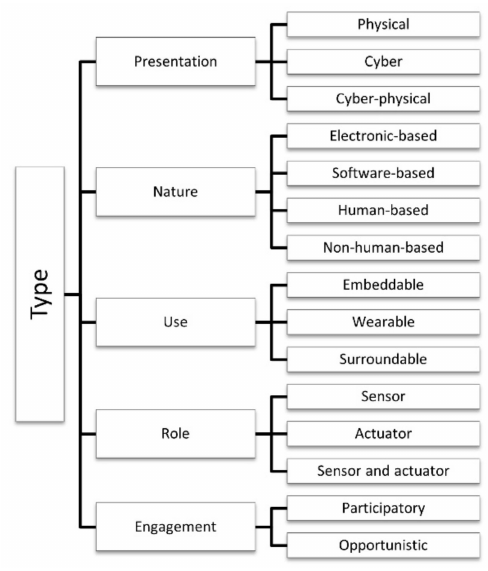
Figure 4. IoE Taxonomy: type category, its dimensions, and